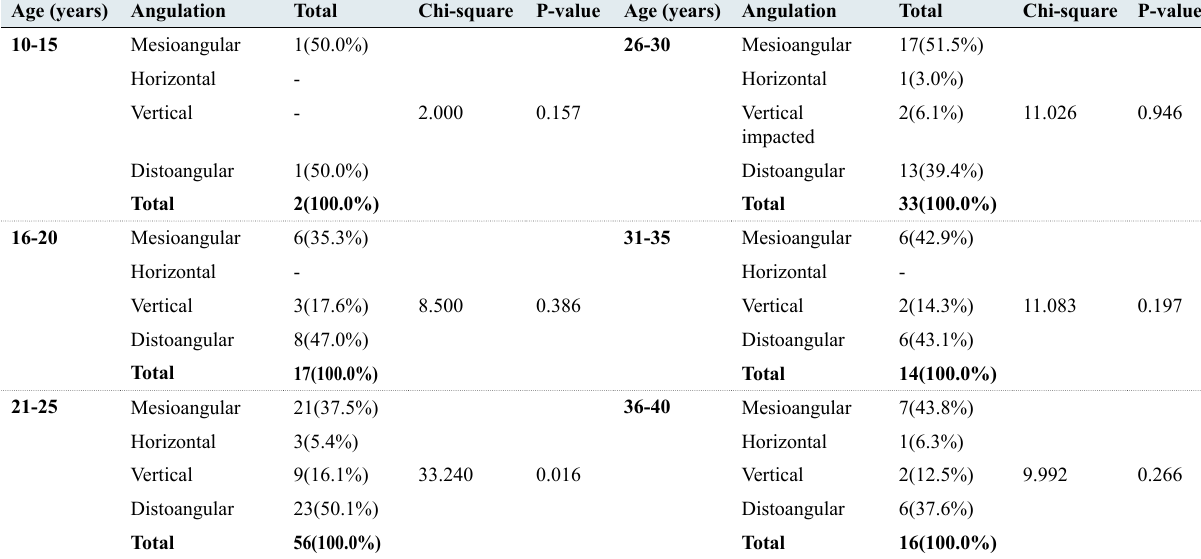
Table 1: Placement of pattern of impaction between various age classes Age (years) Angulation